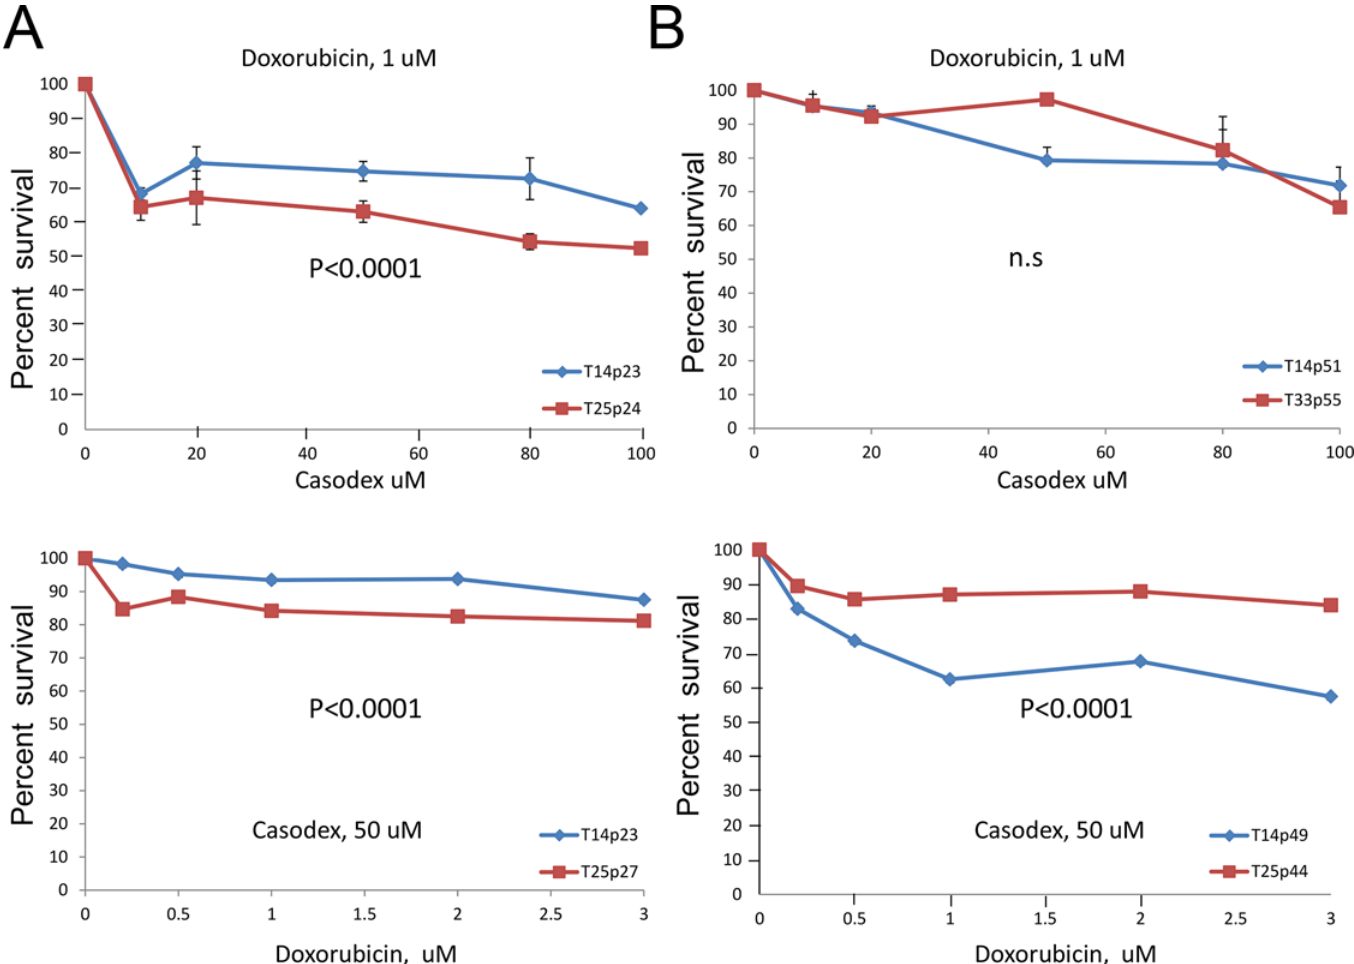
Fig 3. Sensitivity of TOP2A overexpressing cells to combination treatment with TOP2A poison and anti-androgen. A) Survival of TOP2A clones of early passage in response to combination treatment: top panel- constant dose of doxorubicin and increasing concentrations of casodex; bottom panel- constant dose of casodex and increasing concentrations of doxorubicin. B) Survival of TOP2A clones of late passage in response to combination treatment, drugs and concentrations are as in a. Data are presented as mean ± SD, based on 3 independent experiments. P values are as indicated, n.s. is not